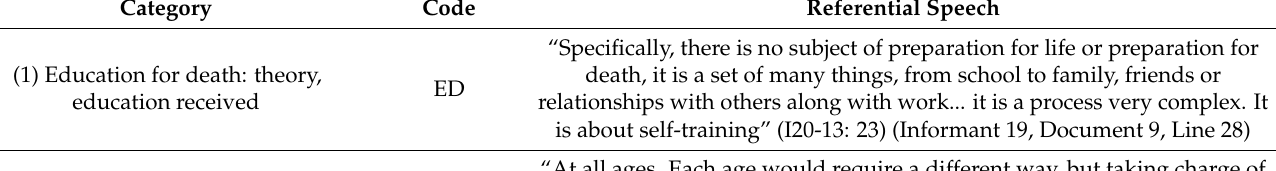
Figure 2. Semantic network Atlas.Ti.